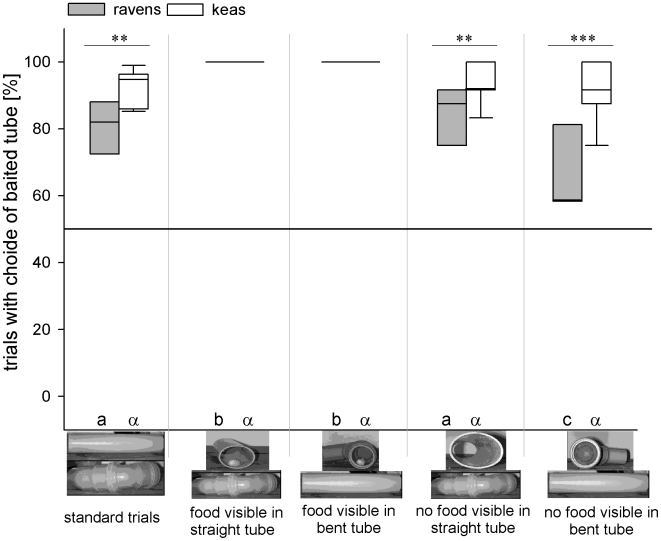
Percentage of trials in which the baited tube was chosen in the different conditions by ravens and keas.Box plots show median and upper and lower quartile. Whiskers indicate 10%- and 90% - confidence interval. Horizontal line indicates 50% chance level. Pictures below x-axis show the condition-specific tube arrangement. Between-species differences within conditions are indicated by asterisks (post-hoc Holm-Sidak analysis). Within-species differences between conditions are indicated by different letters below the bars. Roman letters (a, b, c) refer to comparisons within ravens, greek letters (α) refer to comparisons within keas. Bars marked with different letters differ significantly from each other (post-hoc Holm-Sidak analysis).